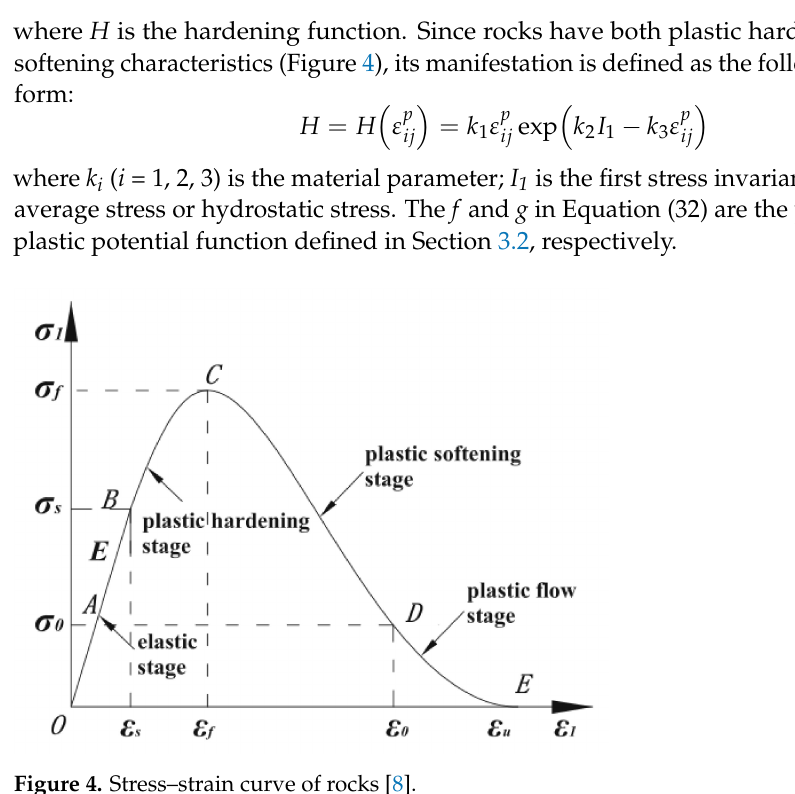
Figure 4. Stress–strain curve of rocks